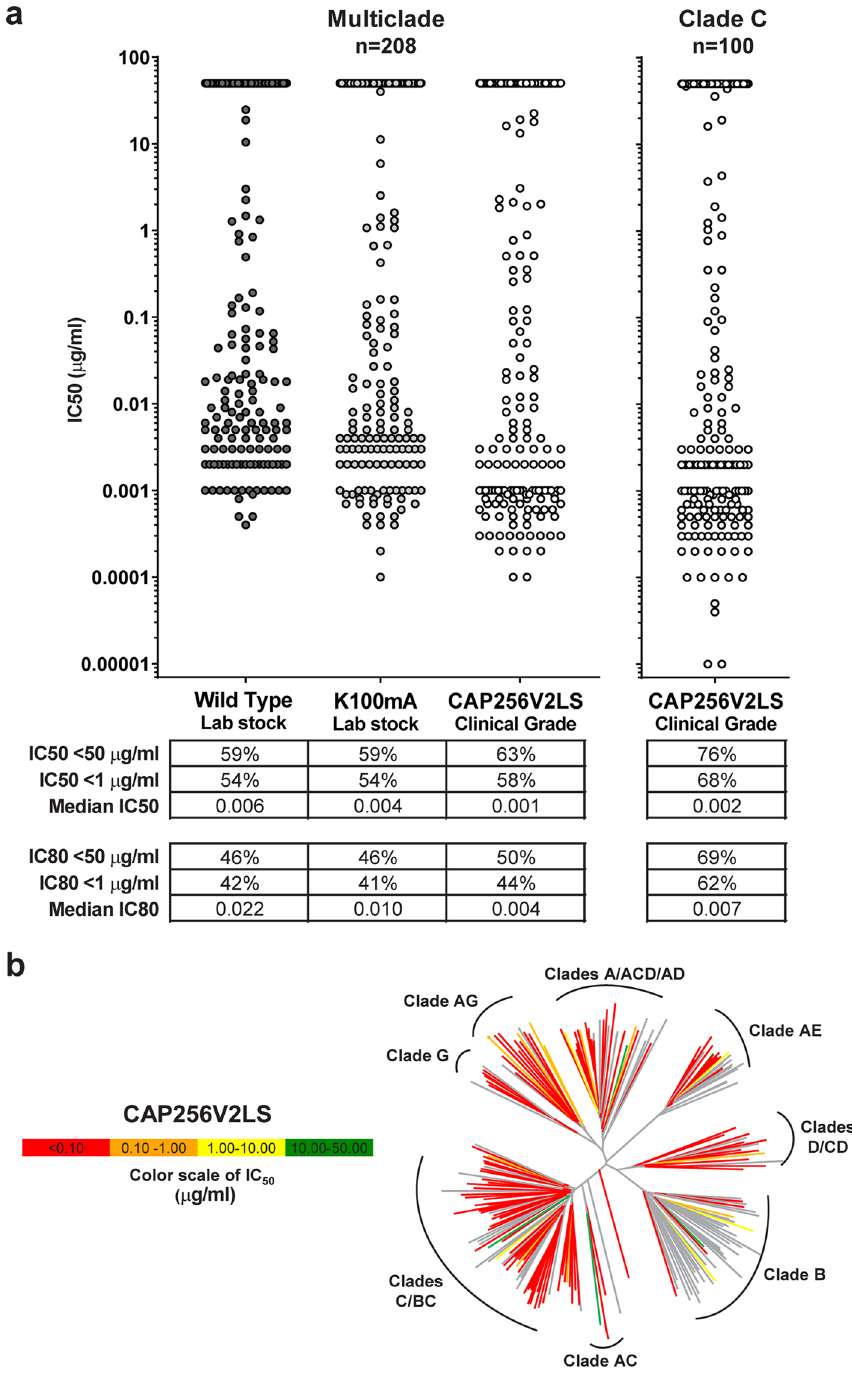
Figure 3. K100mA mutant maintains breadth and potency as assessed on large virus panels. ( a ) Neutralization by CAP256-VRC26.25 wild type, K100mA, and CAP256V2LS was measured against a multi-clade 208 Env- pseudovirus panel (left) and 100 acute Clade C Env-pseudoviruses (right). Each dot represents one pseudovirus. ( b ) Dendrogram shows phylogenetic relatedness of Env sequences in multi-clade panel, color-coded by neutralization